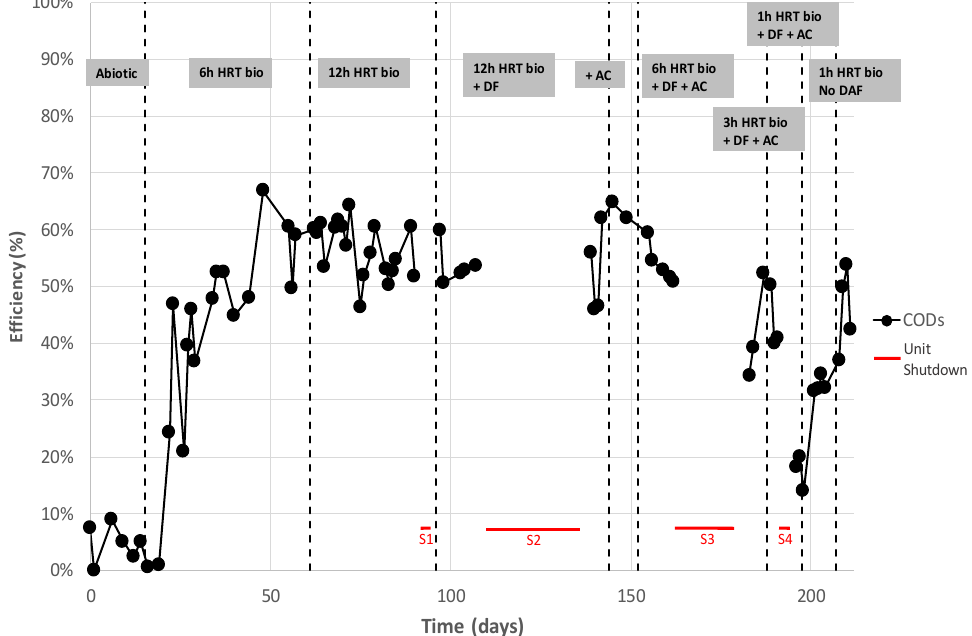
Figure 13. Soluble COD removal during the entire pilot operation phases.